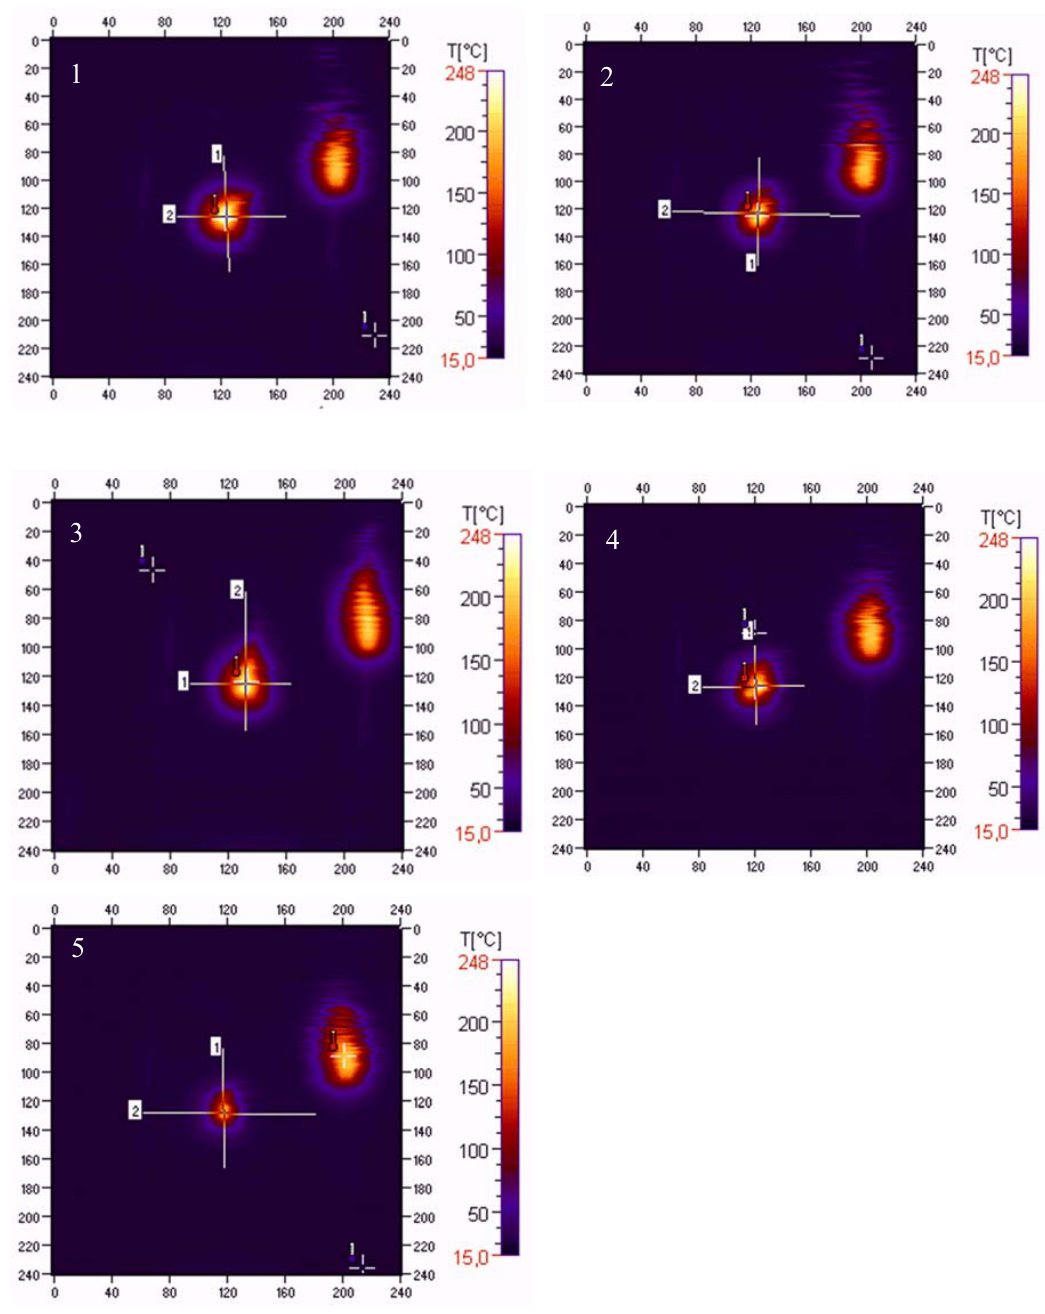
Figure 10. Photos of the samples made using a thermographic camera ( 1 ) 0%P + 0%L, ( 2 ) 0%P + 5%L, ( 3 ) 0%P + 5%LP, ( 4 ) 2%P + 5%L, ( 5 ) 2%P +